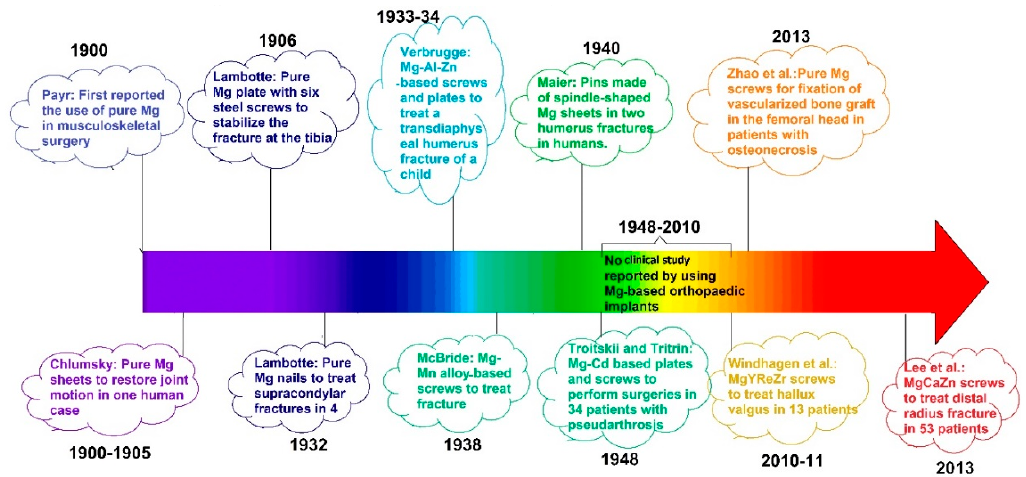
Figure 2. Historical background concerning clinical examination of Mg-based orthopedic devices reproduced from [39], with permission from Elsevier, 2017.